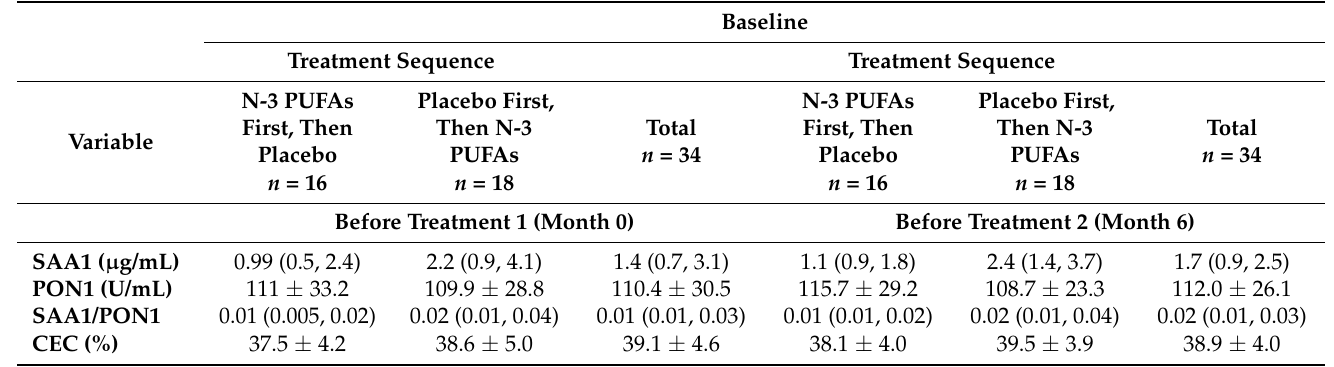
Table 4. Table 3. High-density lipoprotein function at baseline presented by sequence, treatment period, and total.